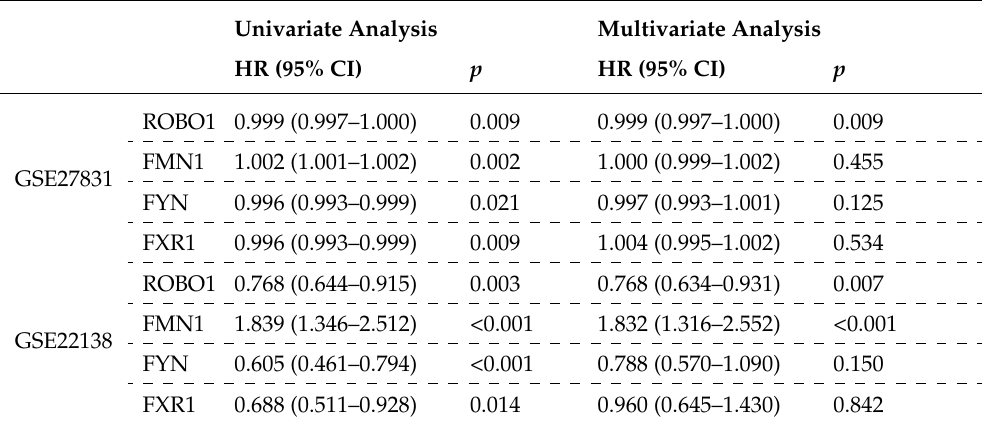
Table 5. Prognostic factors affecting metastasis-free survival of the study